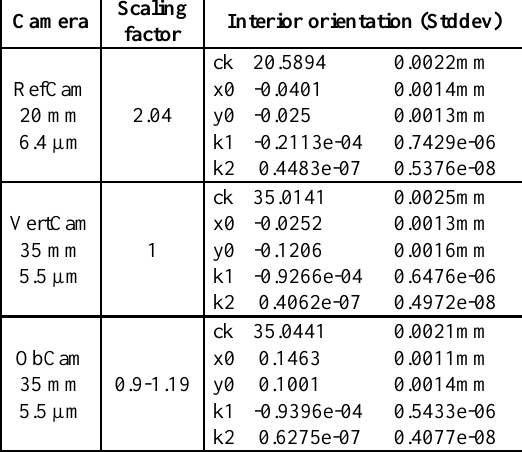
Table 2. Camera parameters